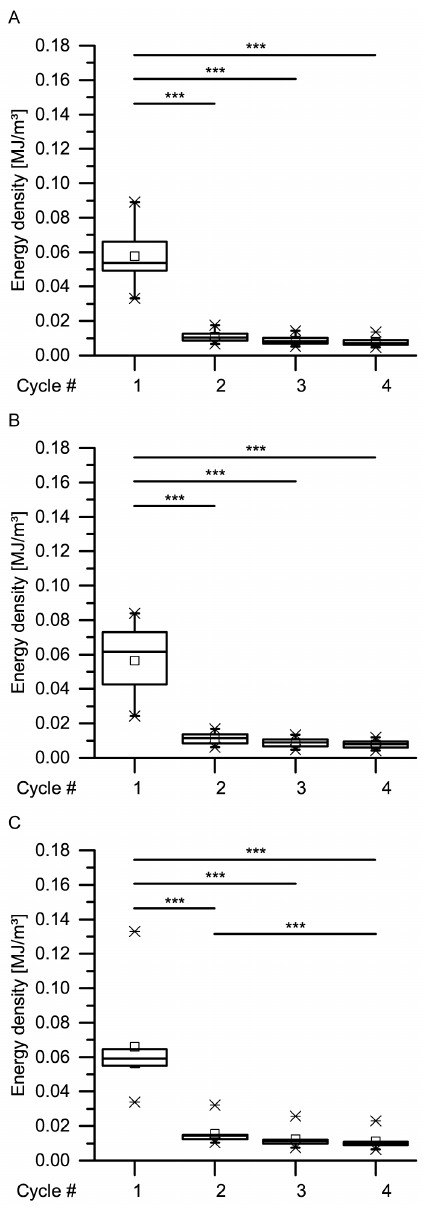
Figure A1. Energy densities of the loading curves (absorbed energy E a ) of the quasistatic cyclic compression tests with unchanged maximum compression, at strain rates of 0.01 min − 1 ( A ), 0.1 min − 1 ( B ) and 1 min − 1 ( C ) (statistical test: Kruskal–Wallis test; n = 10 for each group). Significant di ff erences are marked by asterisks, with the levels of significance indicated as follows: *** p <